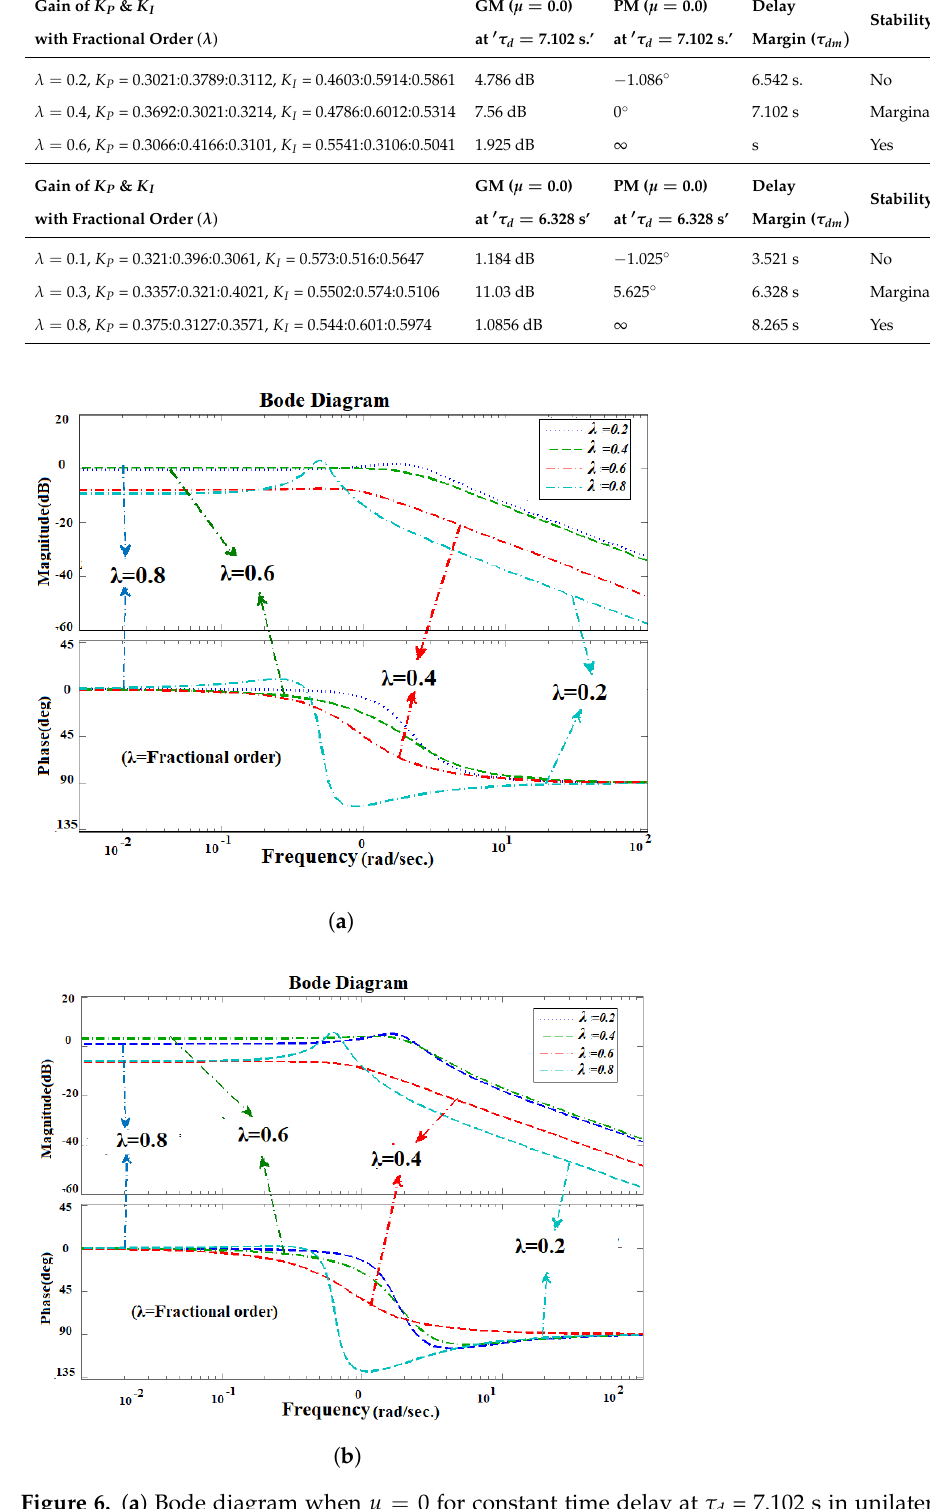
Figure 6. ( a ) Bode diagram when µ = 0 for constant time delay at τ d = 7.102 s in unilateral case. ( b ) Bode diagram when ( µ = 0) for time delay at τ d = 7.234 s in the unilateral